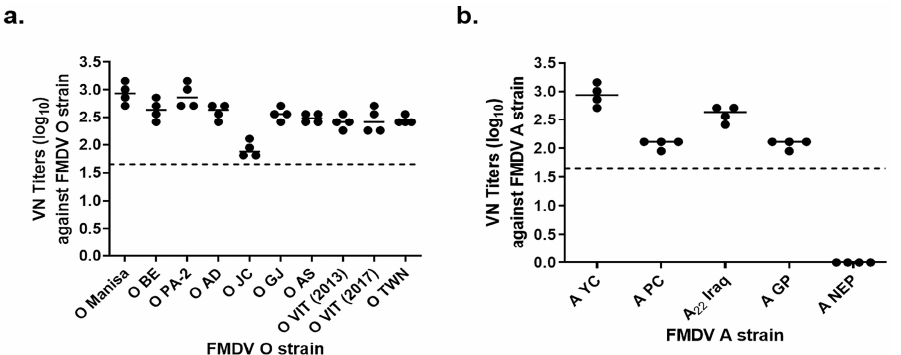
Figure 1. Neutralizing antibodies against various FMDV strains induced in intradermally vaccinated swine. The test vaccine was administered to swine at 15 µg O PA-2 + A22 Iraq antigen, ISA207 (oil-based emulsion, 50%, W/O/W), 10% Al(OH)3, and 1% Saponin. ( a ) Viral Neutralization (VN) titers against FMDV O strains; ( b ) VN titers against FMDV A strains. In guinea pigs, the results of type O structural protein (SP)-ELISA showed that both the IM and ID groups, the average PI value was 50% at 21 dpv and >80% at 35 dpv (Figure 2a). At 21 dpv, both groups (IM and ID) showed VN titers of ≥1:100 in experiments evalu- ating the neutralizing antibody titer against the homologous type O PA-2 strain (Figure 2b). The results of type A SP-ELISA were positive in both groups (IM and ID) at 28 dpv; the VN titers were lower than those of type O but showed a similar tendency (Figure 2c,d).